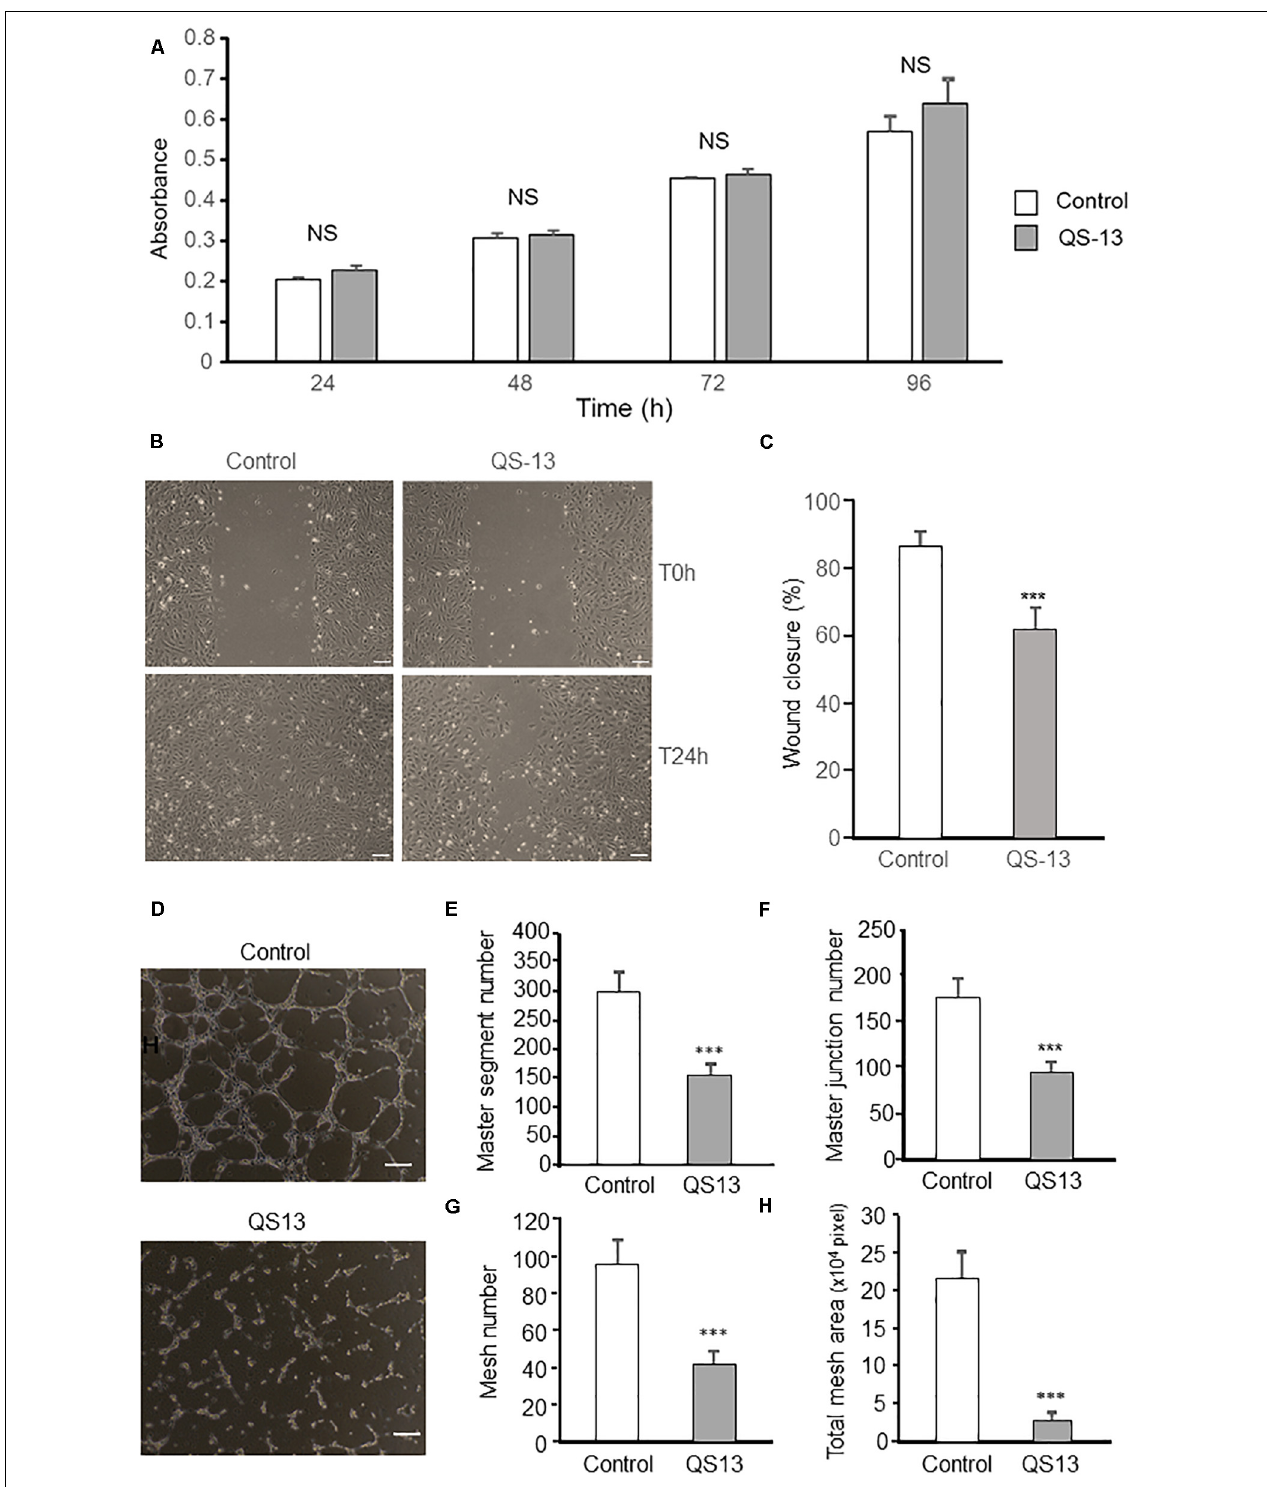
FIGURE 2 | QS-13 decreases in vitro endothelial cell migration and pseudotube formation without affecting cell proliferation. To study cell proliferation, HUVECs were incubated for 24, 48, 72, and 96 h with or without 40 µ M QS-13. (A) Proliferation was measured using the WST-1 reagent and absorbance was read at 450 nm ( n = 8). Three independent experiments were carried out. The histogram represents the means ± SD of the more representative one. NS, not significant. To study